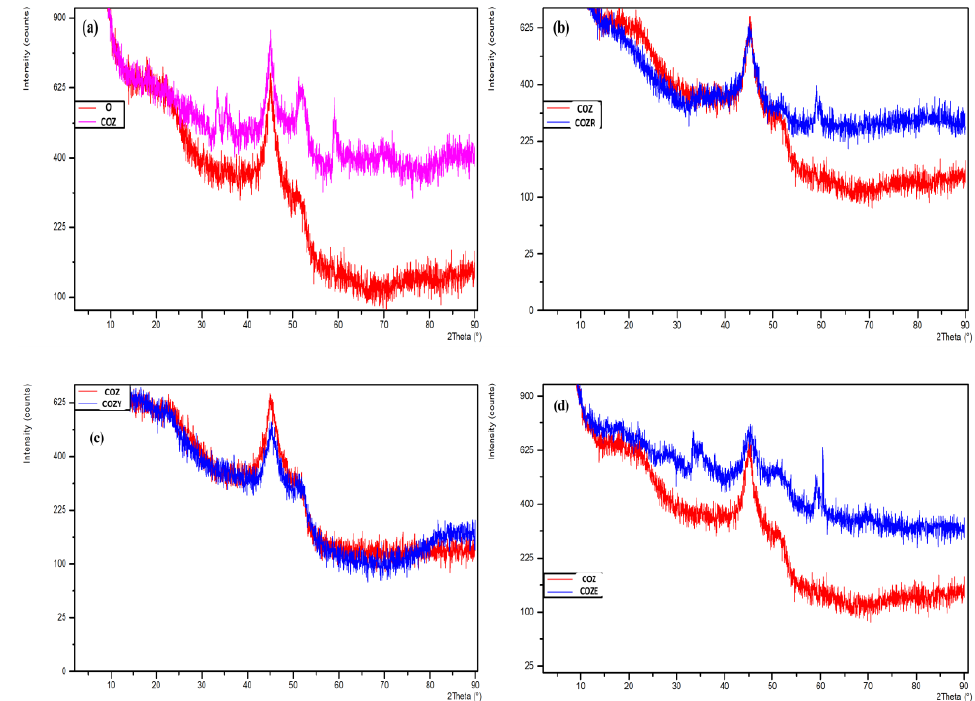
Figure 3. XRD analysis of ( a ) oak [ O ] before coated and after coated with ZnO [ COZ ], ( b ) COZ before and after adsorption with red hair dye [ COZR ], ( c ) COZ before and after adsorption with yellow hair dye [ COZY ], and ( d ) COZ before and after adsorption with Ebony hair dye [ COZE ] .